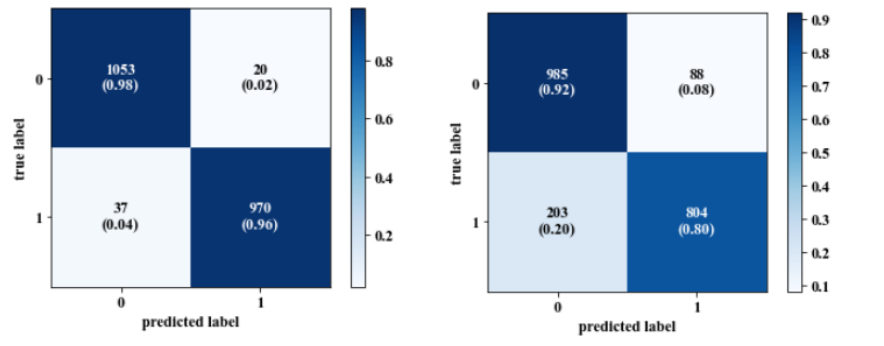
Figure 7. Confusion matrix for generic model ( left : spatial images; right : frequency domain images).